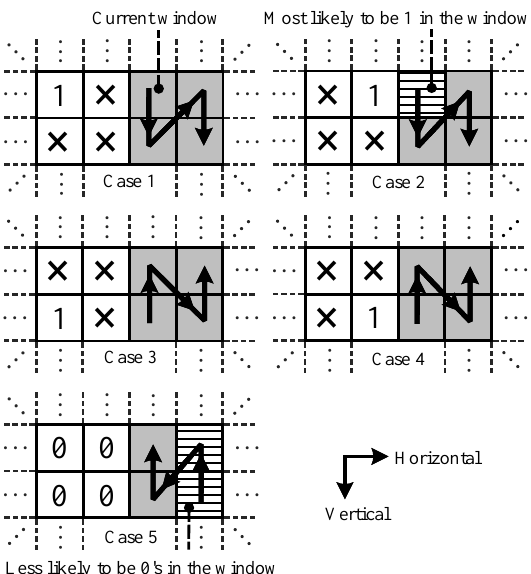
Figure 2. Compute ordering technique.